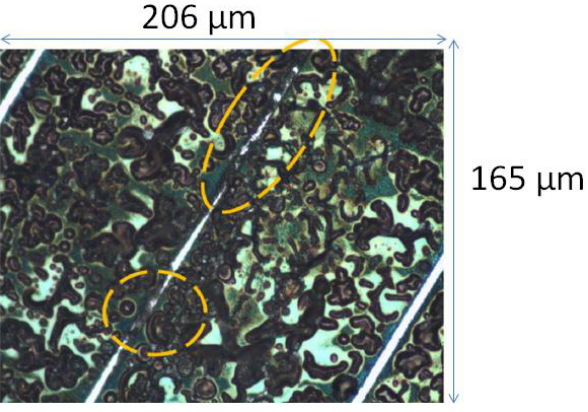
Figure 1. Optical microscopy picture of a polypyrrole film electrodeposited on platinum microelectrode arrays (gap between the arrays: 5